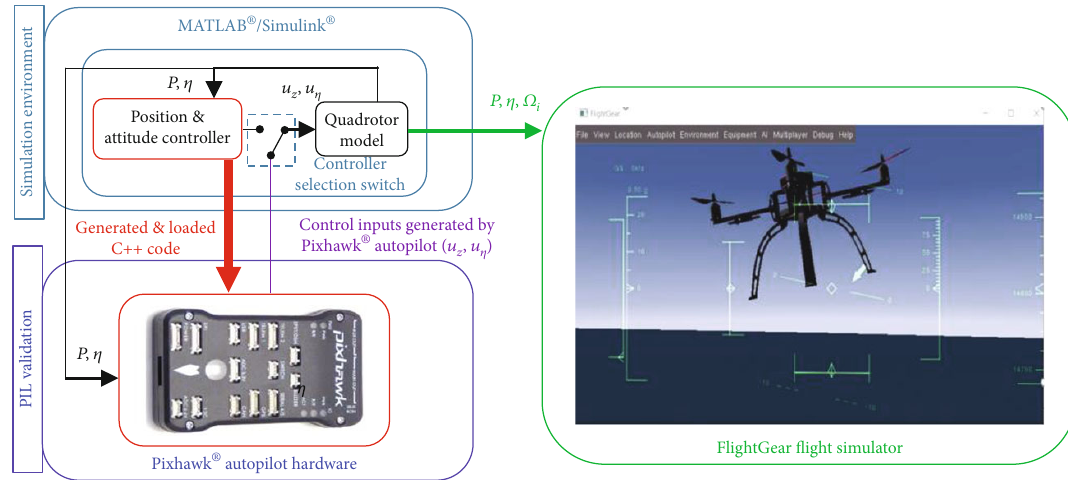
Figure 3: Block diagram of the implementation process from the simulation phase to the real autopilot hardware following an MBD procedure.